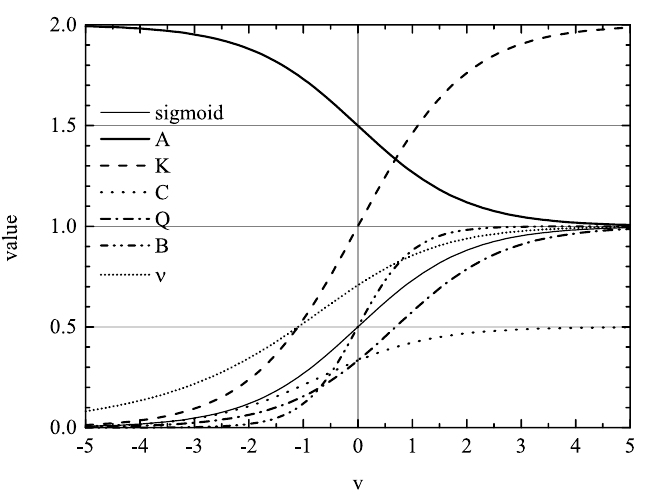
Fig. 3. The shape of generalized logistic function for some changed values of parameters (see